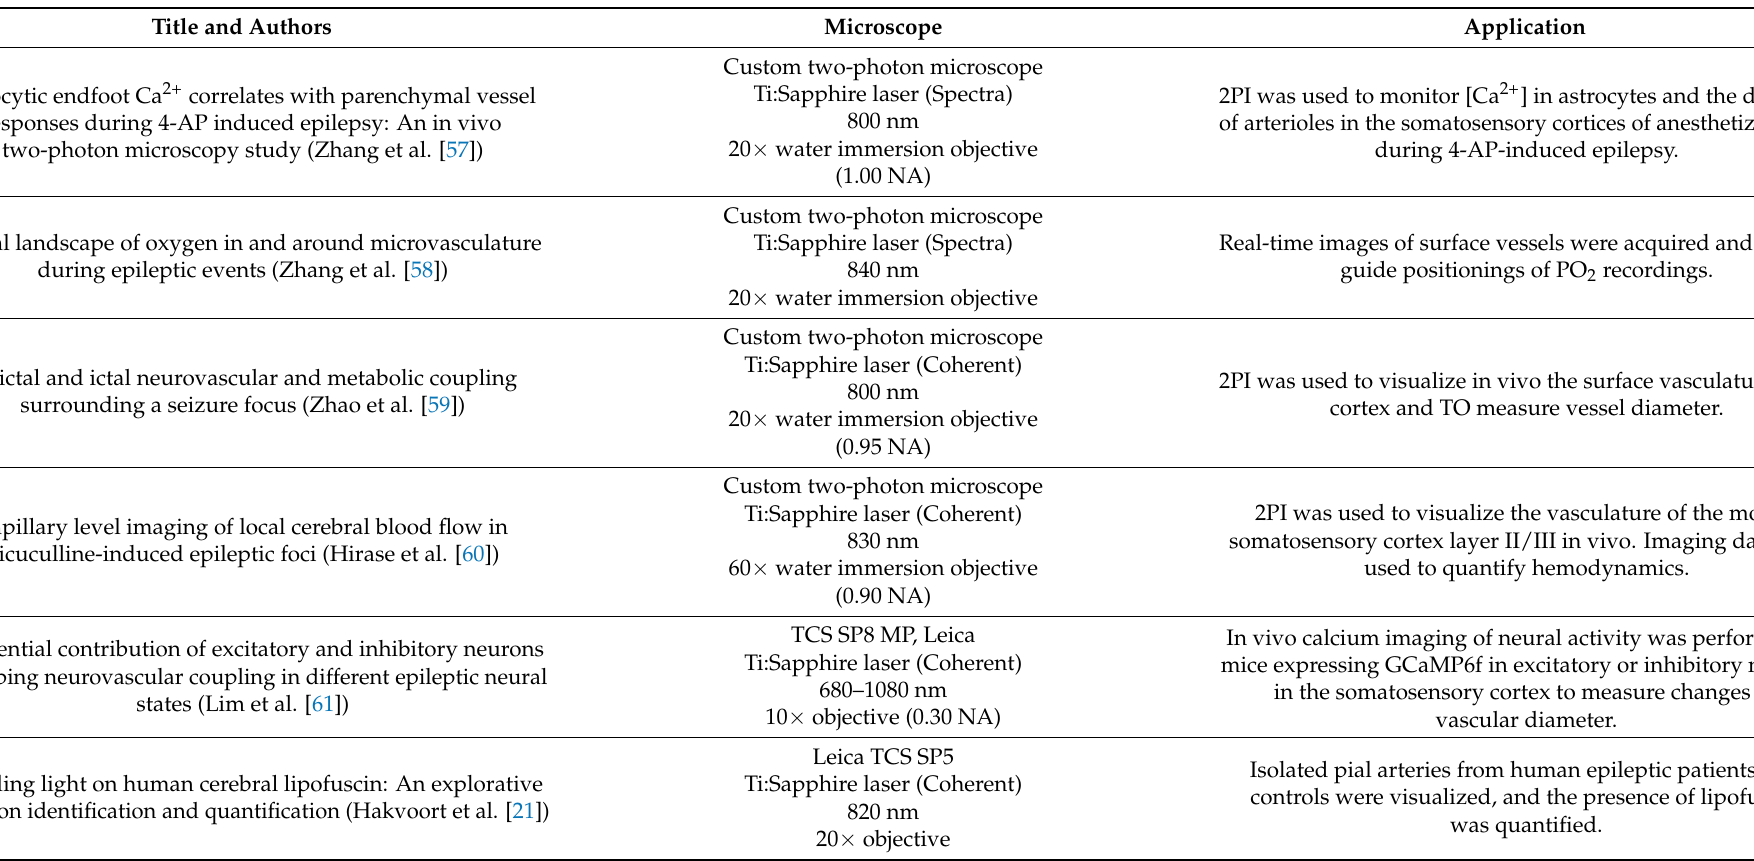
Table 4. Neurovasculature—data abstraction table catalogues the type of two-photon microscope used and how 2PI was applied in each study within this group of